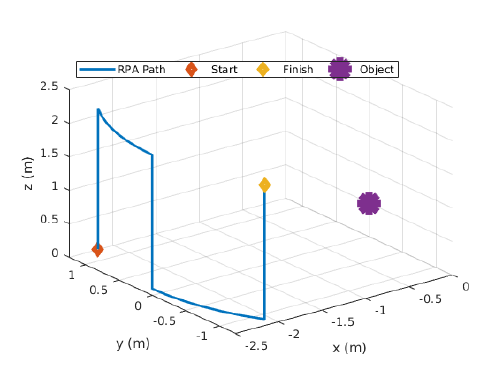
Figure 13. Practical experiment